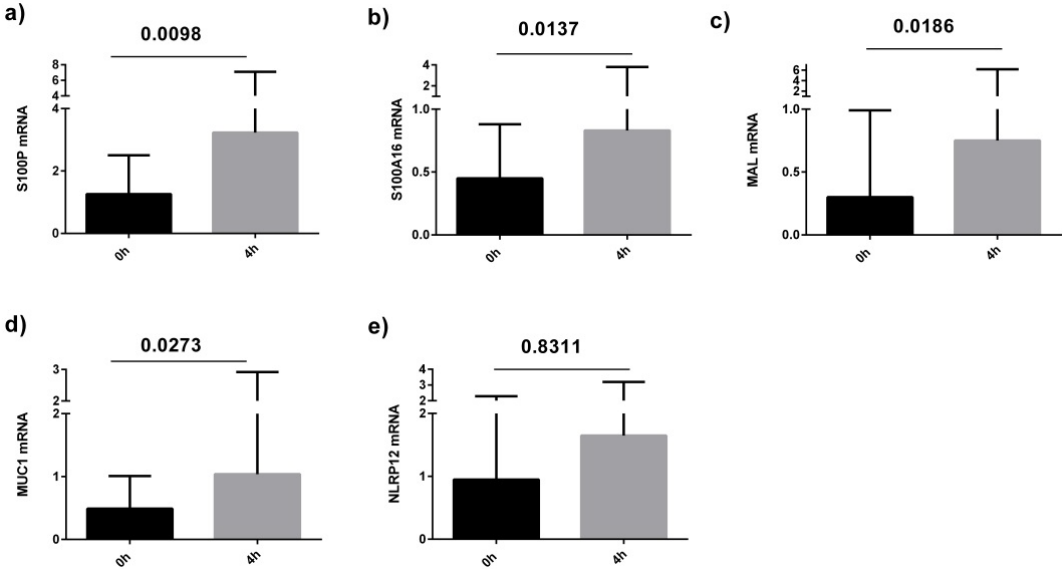
Figure 2. Level of sputum cell gene expression (measured by qPCR) in asthmatics at baseline and 4 h after a high fat meal; ( a ) S100P; ( b ) S100A16; ( c ) MAL; ( d ) MUC1; ( e ) NLRP12.